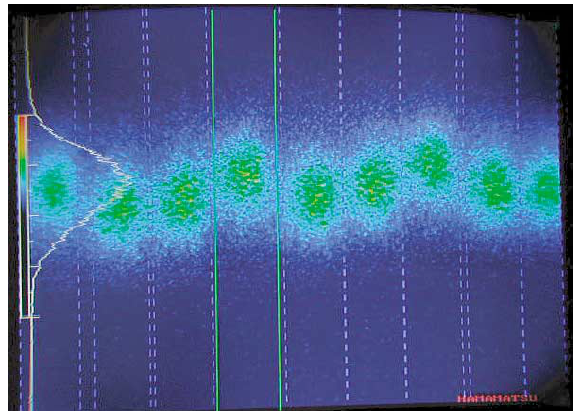
FIG. 26. (Color) (a) A typical longitudinal profile of a train fit to an asymmetric Gaussian function. (b) At each beam current, the standard deviation train oscillation was determined with stable and unstable